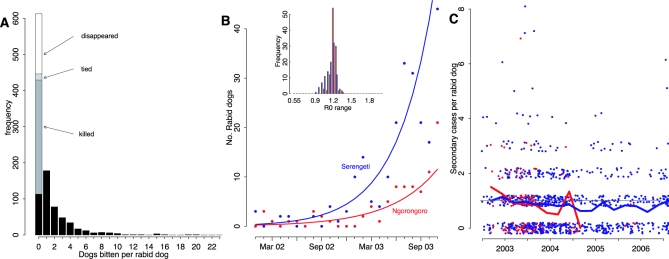
Transmission of Rabies(A) The distribution of dogs bitten per rabid dog (fitted by a negative binomial distribution with mean = 2.15 [95% CI: 1.95–2.37]; variance = 5.61 [95% CI: 4.63–6.92]; shape parameter k = 1.33 [95% CI: 1.23–1.42]; R0 ∼ 1.1). To calculate R0, we excluded dogs that were killed, tied, or those that disappeared before biting any other dogs. Variability in biting behaviour means that a small number of individuals disproportionately affect transmission and can potentially spark an epidemic, but since most individuals cause few, if any, infections, R0 is low and most introductions quickly die out (Figure 4C).(B) Exponential epidemic growth in Serengeti (blue, R0 ∼ 1.2) and Ngorongoro (red, R0 ∼ 1.1) districts. The R0 estimates from the epidemic trajectories were relatively insensitive to the period used for fitting the exponential curve. The inset shows the distribution of R0 estimates based on fitting to different regions of the time series.(C) The effective reproductive number, R, (averaged over three-month intervals) for Serengeti (blue) and Ngorongoro (red) districts measured from reconstructed epidemic trees that incorporate prior knowledge on who infected whom. Dots indicate the number of secondary cases resulting from each primary case (inferred from the composite tree of most likely links, with random jitter to avoid superposition on the y-axis). R0 estimated from these reconstructions (during the period of exponential epidemic growth) was ∼1.1 and ∼1.3 for Serengeti and Ngorongoro, respectively.